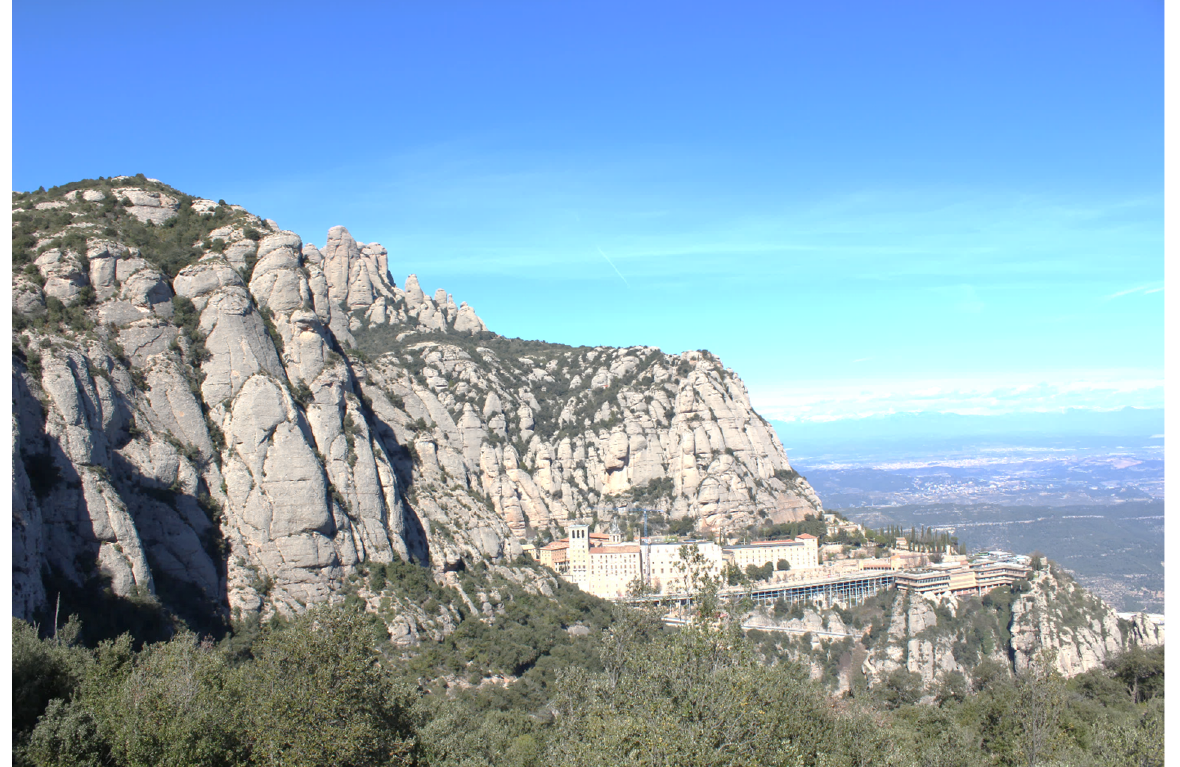
Figure 18. General view of the Montserrat massif (50 km northwest of the city of Barcelona, Spain) near the monastery.